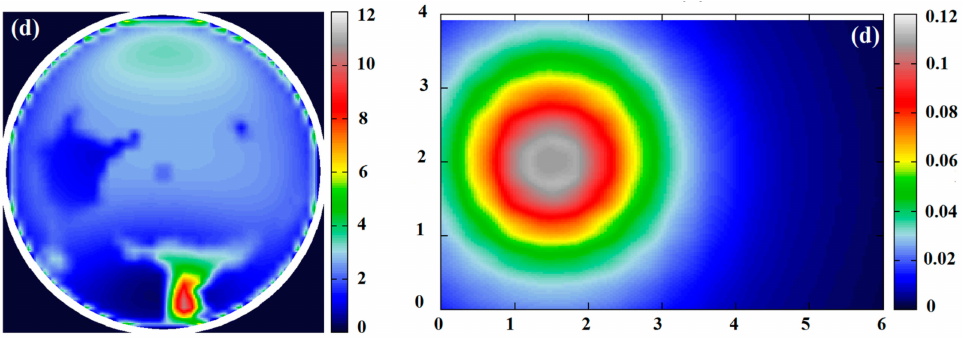
Figure 4. The same as in Figure 3 but for a solar altitude at 15 ◦ . Room dimensions are in meters (see plots on the right side of the figure); Corresponding cloud fractions: ( a ) 0.0, ( b ) 0.15, ( c ) 0.30, and ( d )